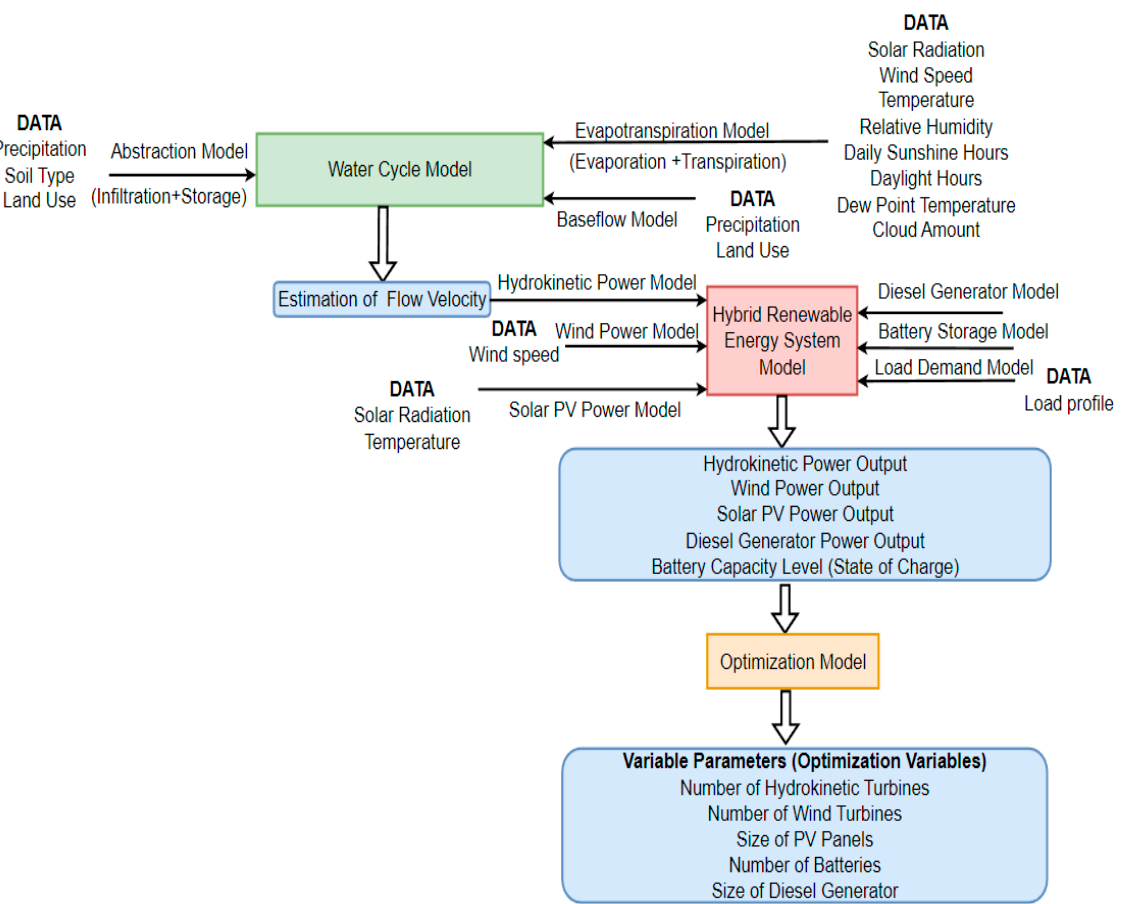
Figure 1. Proposed framework of integrating hydrokinetic power into HRES.